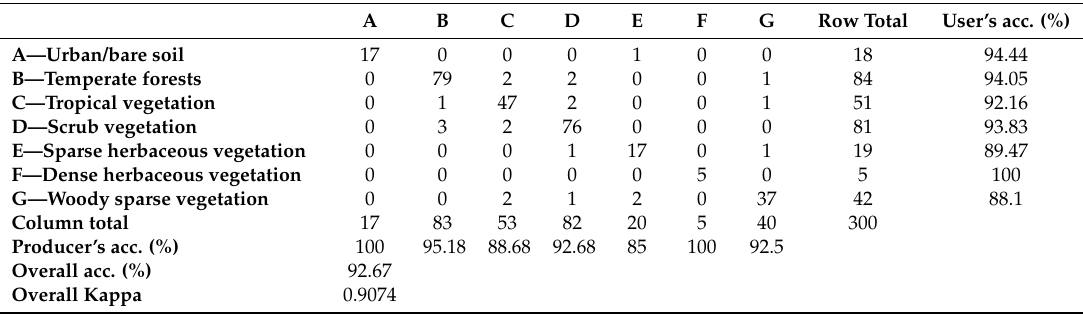
Table 6. Error matrix for land use-cover, 2000. Natural Protected Area Altas Cumbres. Victoria, Tamaulipas, Mexico.